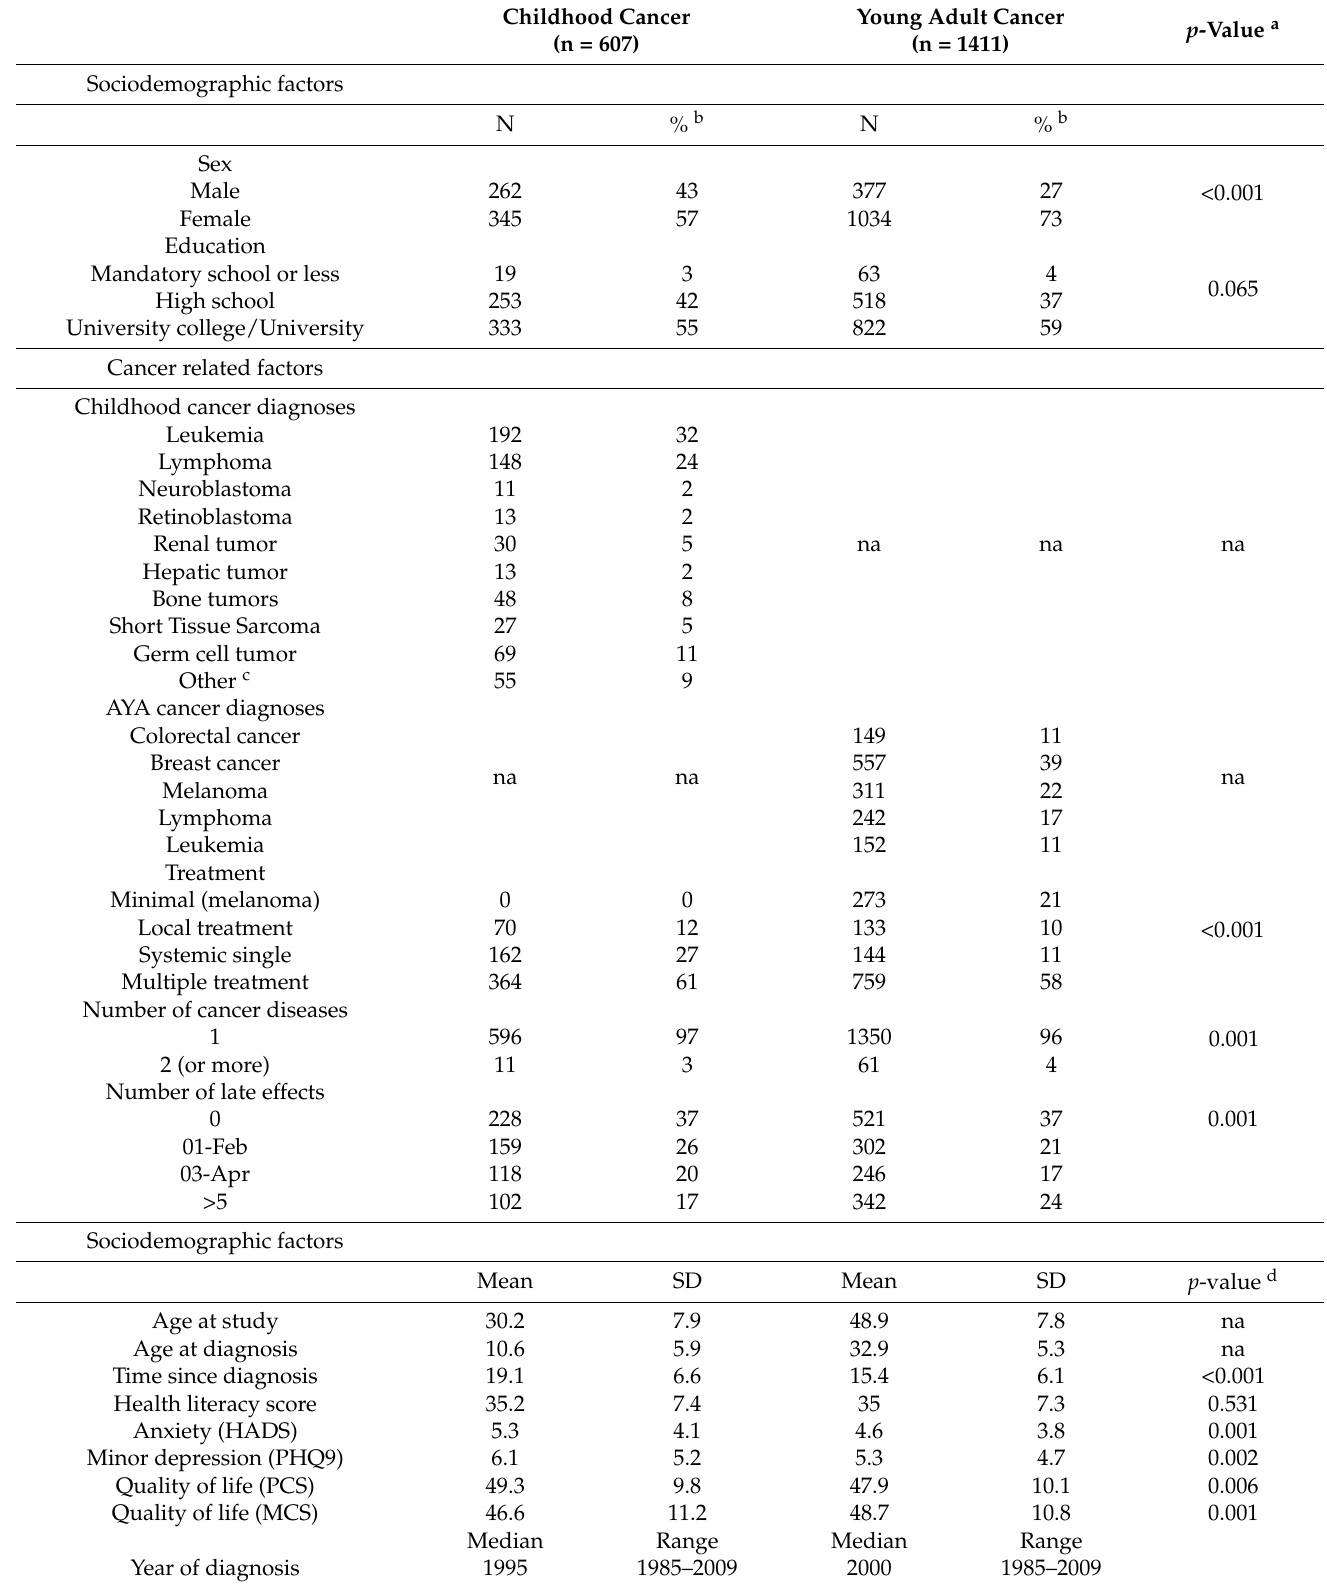
Table 1. Characteristics of the study